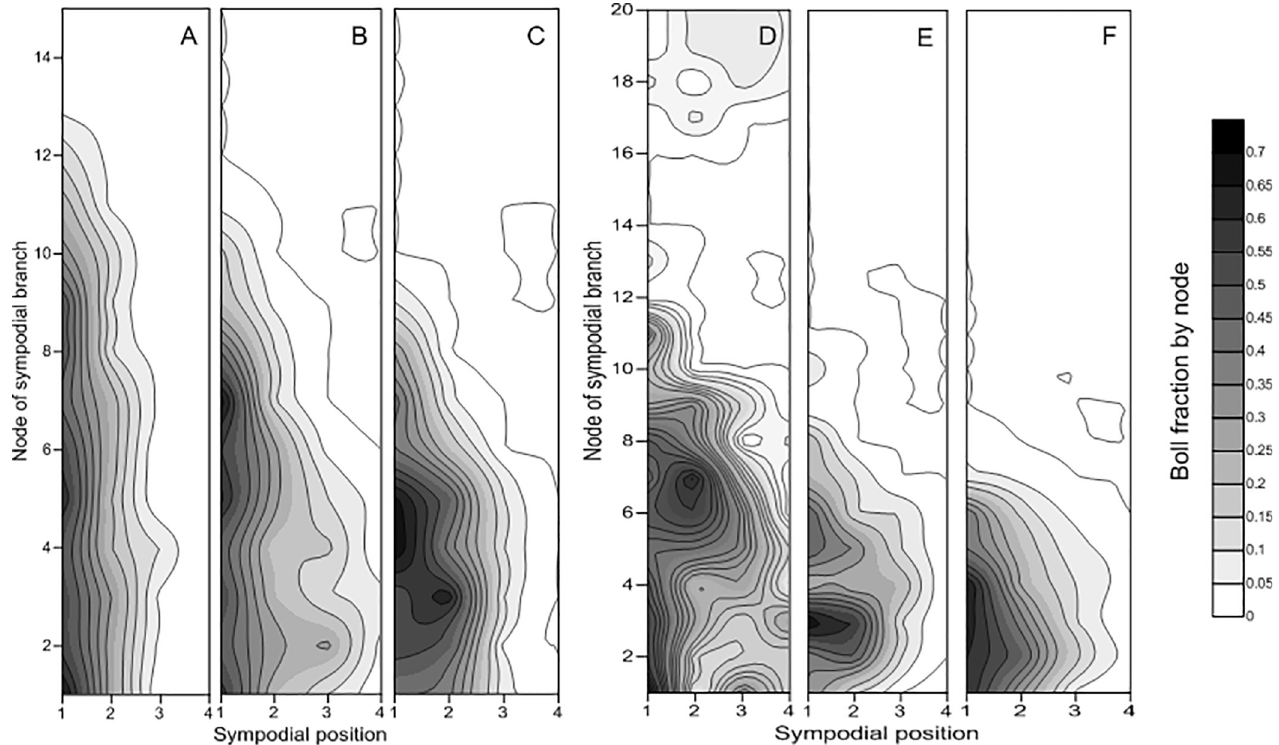
Fig 4. Fraction of bolls of the different planting patterns at 100 DAS in 2016 and 2017. Note: A, B, and C represent the cotton monoculture (CM) system, the cotton/wheat intercropping (CWI) system, and the system in which cotton was directly seeded after wheat (CWD), respectively, in 2016; D, E, and F represent the cotton monoculture (CM) system, the cotton/wheat intercropping (CWI) system, and the system in which cotton was directly seeded after wheat (CWD), respectively, in 2017.